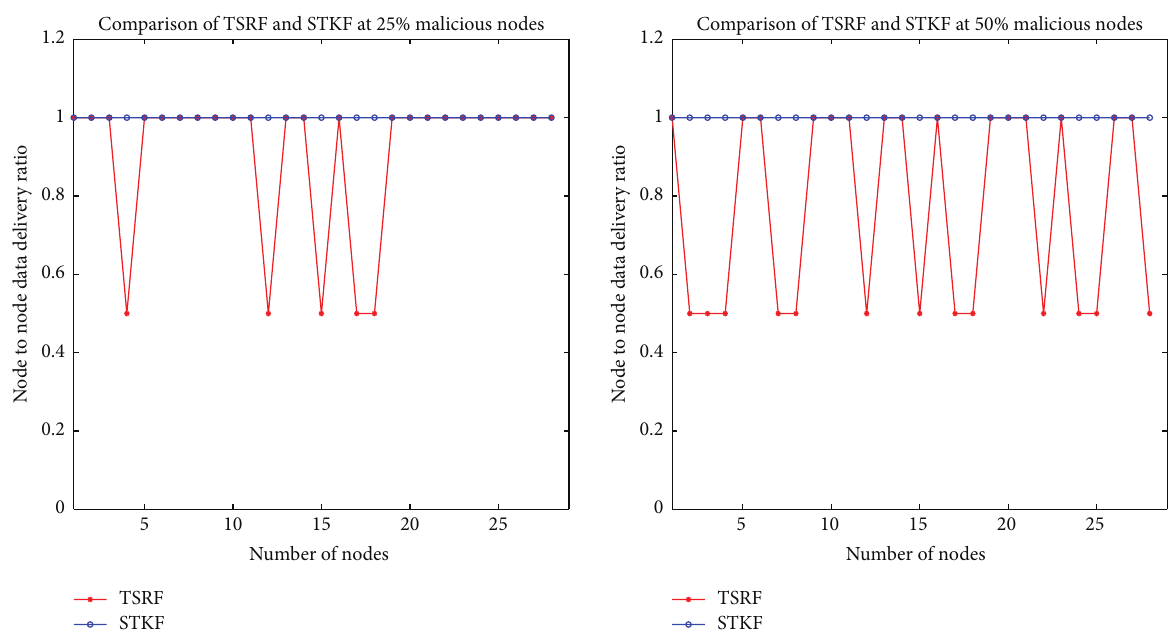
Figure 5: Graphs representing comparison of STKF and TSRF with 25% and 50% of malicious nodes